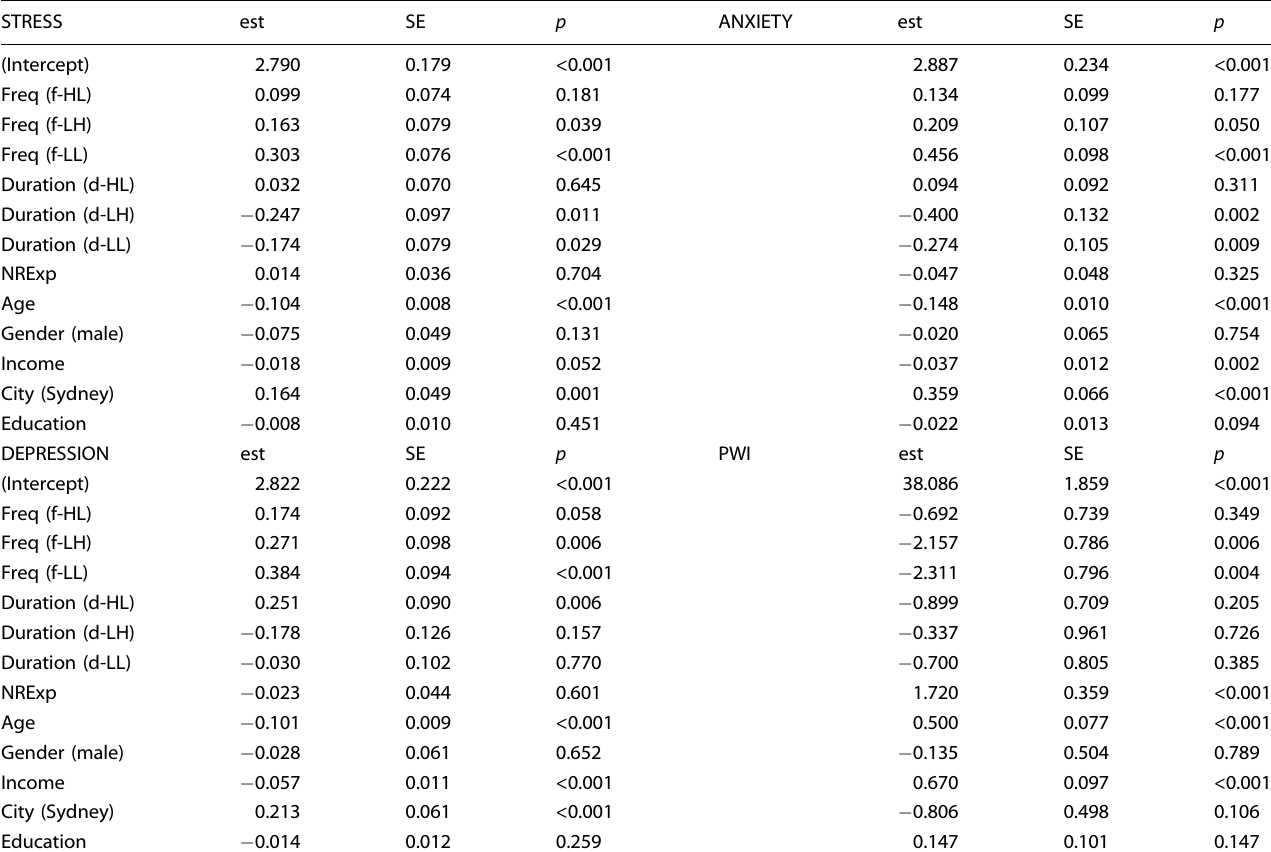
Table 2. Model results examining the relationship between different type of green space (GS) users and stress, anxiety, depression, and wellbeing adjusted for socio-demographic factors.